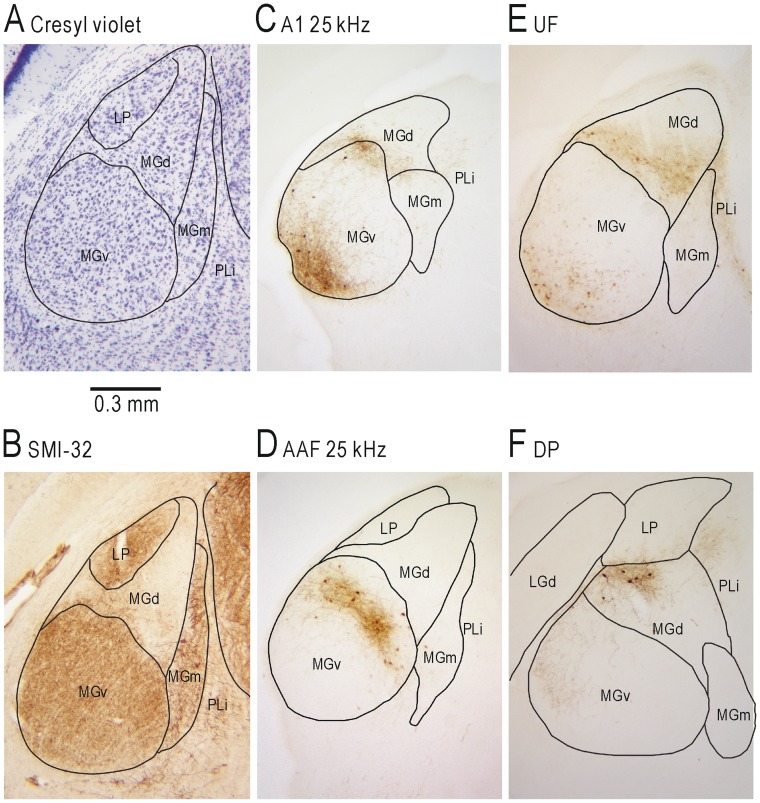
Subdivisions of MG projecting to the auditory cortex.(A) Cresyl violet staining of MG. (B) SMI-32 immunostaining of MG in the adjacent section. (C) BDA staining of MG after BDA injection into the cortical area responding to a 25 kHz AM sound within A1. (D) BDA staining of MG after BDA injection into the cortical area responding to a 25 kHz AM sound within AAF. (E) BDA staining of MG after BDA injection into UF. (F) BDA staining of MG after BDA injection into DP. Sections were approximately 3.0 mm posterior to bregma.